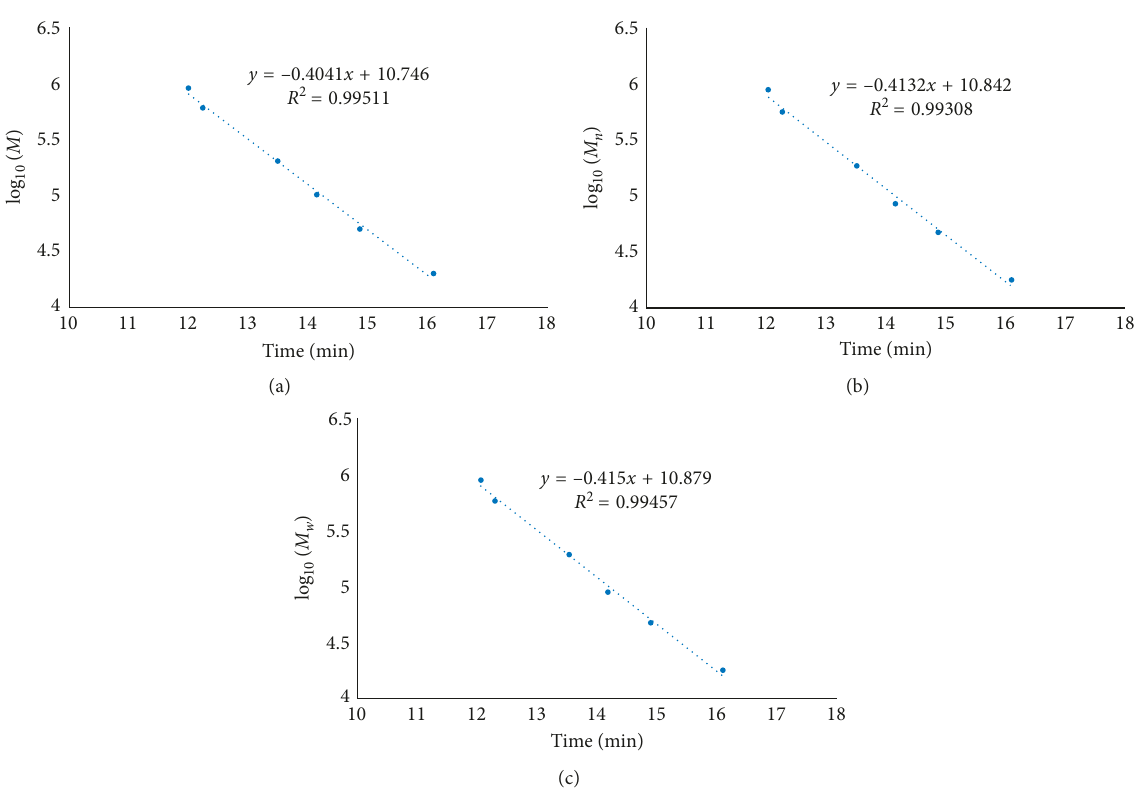
Figure 4: (a) Standard curve of molecular weight of polystyrene; (b) Standard curve of number-average molar mass ( M (c) Standard curve of weight-average molar mass ( M w ) of